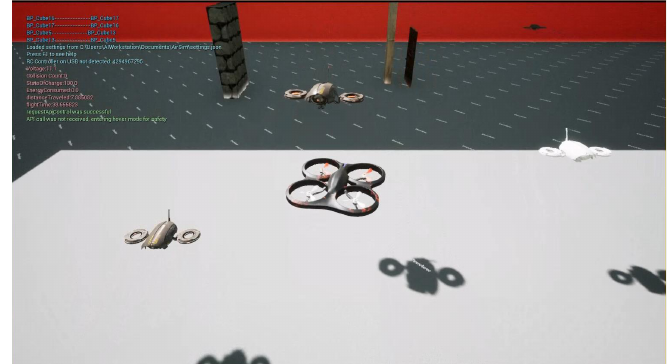
Figure 5. Environment used to test for dynamic obstacle avoidance [30].